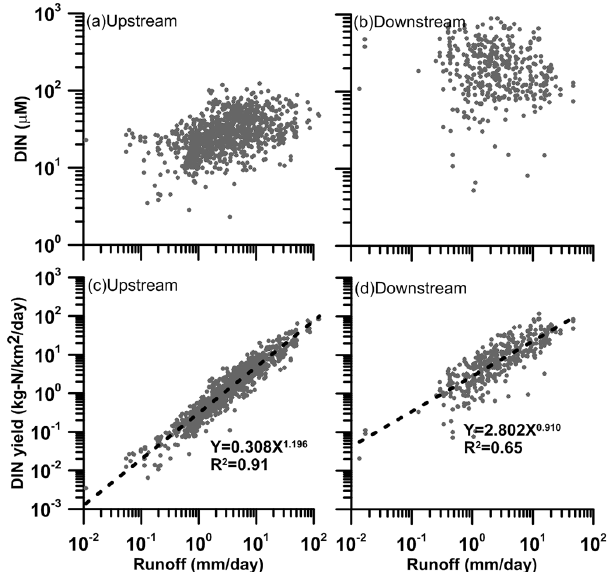
Figure 3. Sampled DIN concentrations and yields plotted against runoff at all upstream (a, c) and downstream sites (b, d) . The dashed lines in (c, d) are power regression equations of the